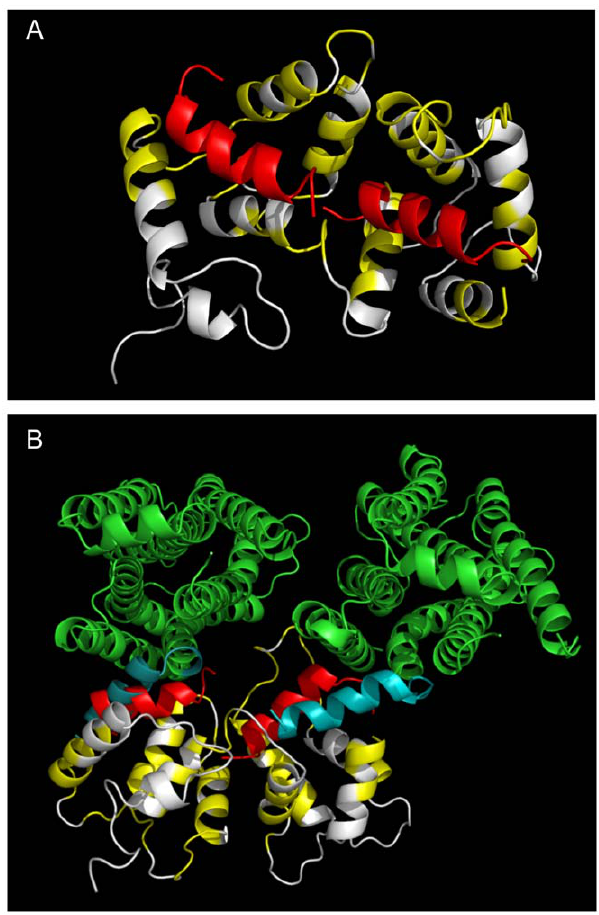
Figure 7. A proposed model of the complex between NCS-1 and the D2/D3 receptor. (A) Model structure of NCS-1 with C-terminal peptide TFNIEFRKAFLKILSC. NCS-1 residues with backbone and side-chain chemical shifts that undergo more than 0.07ppm chemical shift changes or which are completely broadened are coloured yellow. Unaffected NCS- 1 residues are coloured white. The C-terminus D2/D3 peptide (coloured red) were simultaneously docked onto NCS-1 using HADDOCK 2.1 [41]. (B) Structure of NCS-1 with the D3 receptor. This structure is superimposed on the NCS-1-peptide complex described in (a). The receptor is coloured green with its C-terminus coloured teal. The model shows that it is possible to dock two receptors into NCS-1, with the C-terminus peptide placed in similar locations as when using the isolated